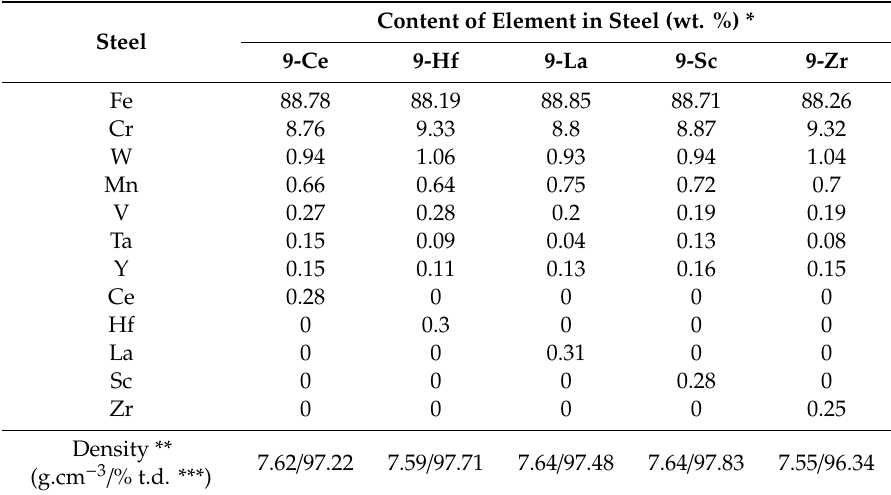
Table 2. Chemical analysis and final densities of the sintered steels.